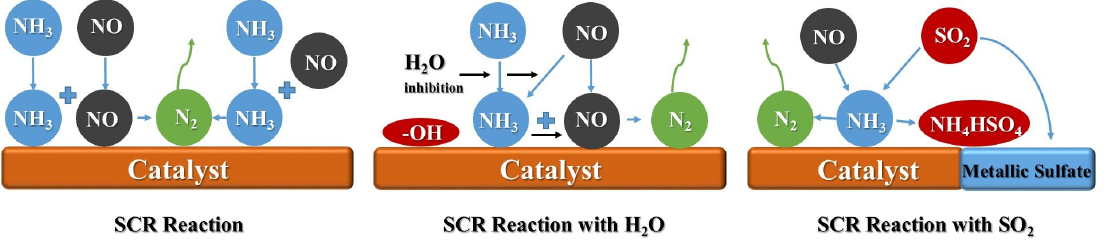
Figure 1. Scheme of the regular selective catalytic reduction (SCR) reaction, the H 2 O poisoning effect, and the SO 2 poisoning effect.